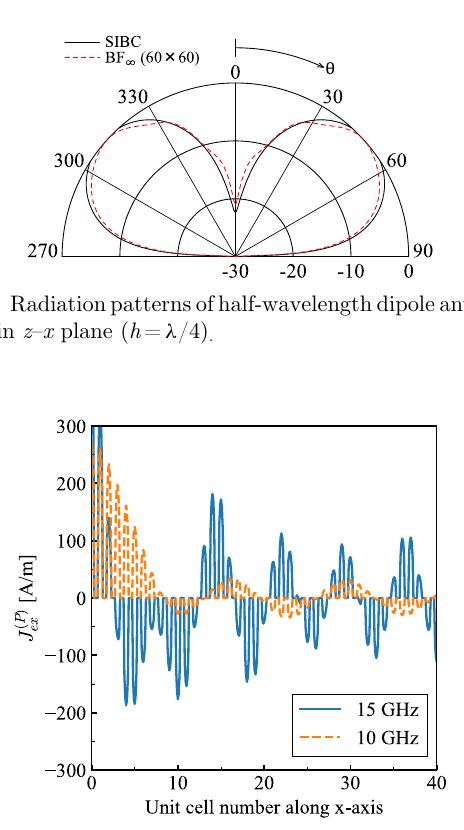
Fig. 11. Surface current density on interface along x axis.